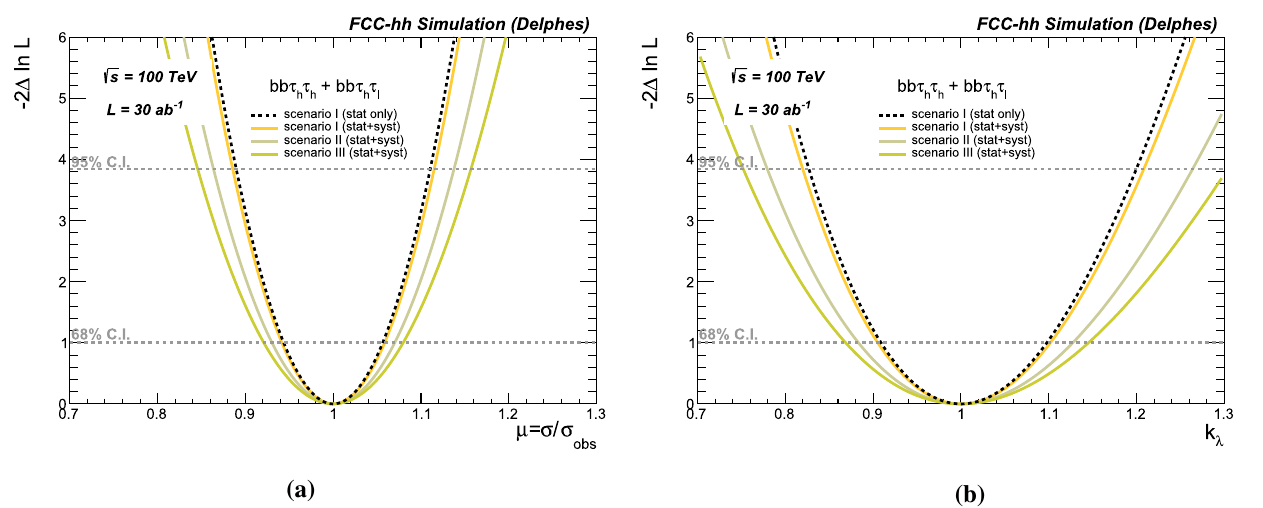
to the different systematic uncertainties assumptions summarized in Table 3. The black dashed line shows the likelihood pro- file when only the statistical uncertainty is included under scenario